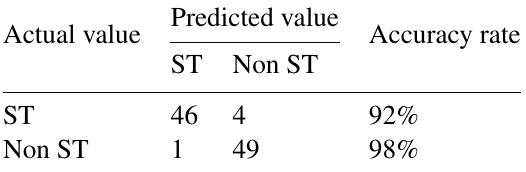
Table 3 Prediction results of generalized estimation equation.